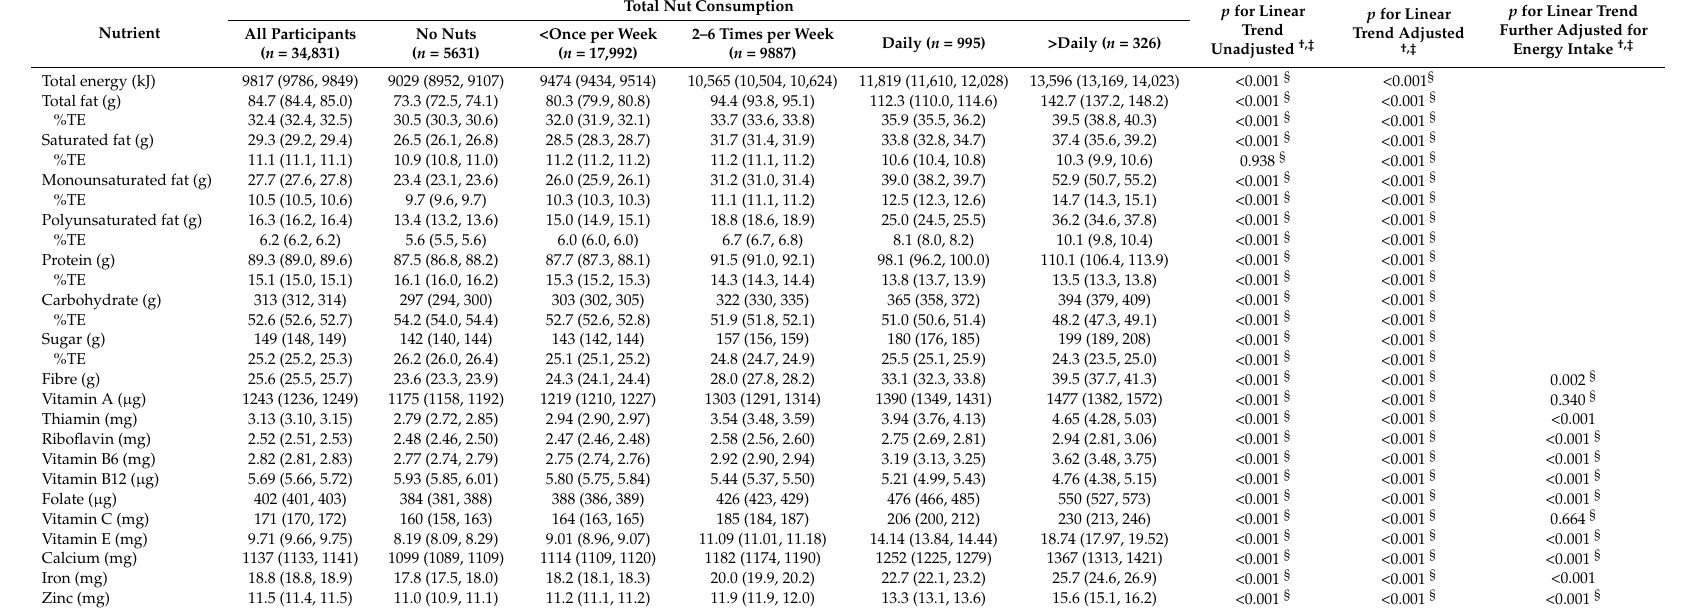
Table 5. Nutrient intakes by nut consumption